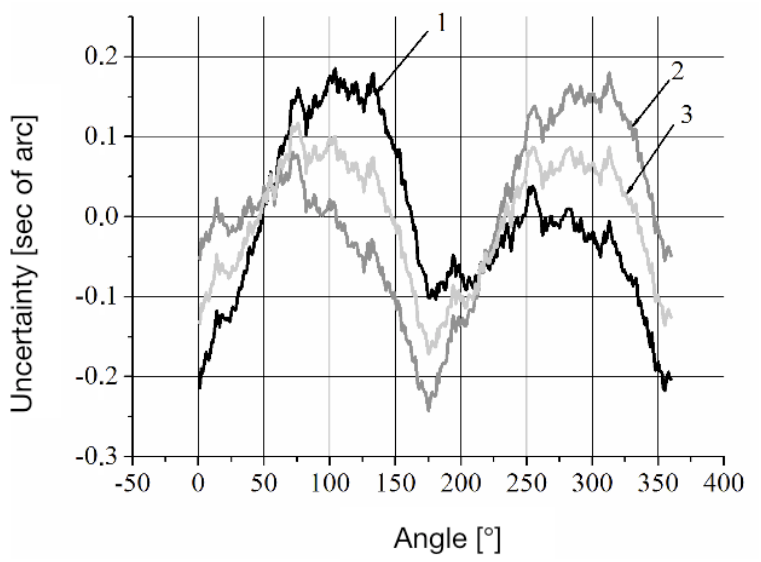
Figure 3. Illustration of the systematic error of the LDG: 1—RL CCW rotation; 2—RL CW rotation; 3—systematic error of the optical